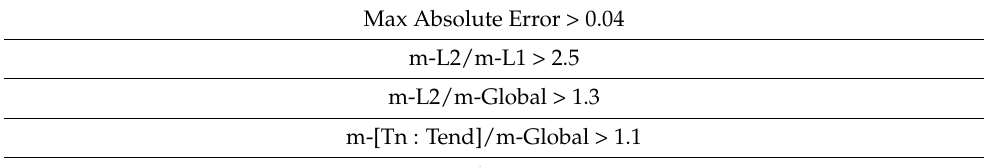
Table 2. Thresholds used as the stopping criteria where, for an anchor point located in i, m-L2 is the slope of the line that approximates the five data points after the anchor point; m-L1 is the slope of the line that fits the five points to the left of the anchor; m-Global is the angular coefficient of the regression line approximating the whole time series; m-[Ti : Tend] ism-L2 the slope of the regression line related to the data from T = i to the last T value; ∆ 2 is the gradient between the points i-1 and i; ∆ 1 is the gradient between the points i-2 and i-1. If all the constraints are met, a breakpoint is defined at the position i-1.